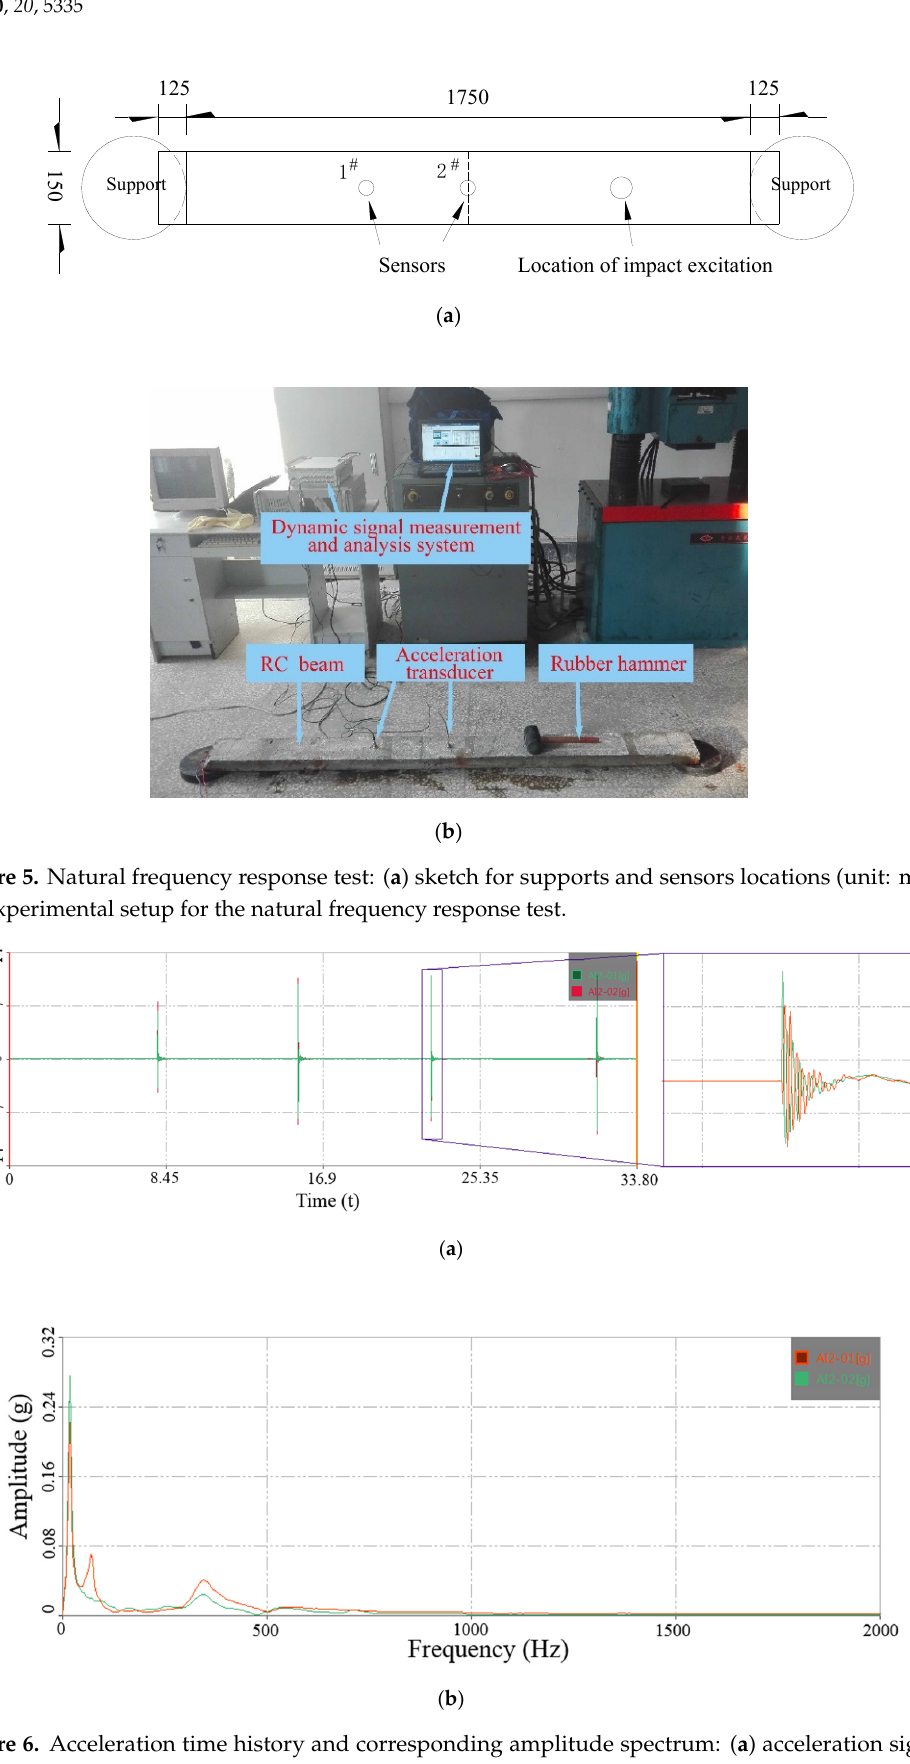
Figure 6. Acceleration time history and corresponding amplitude spectrum: ( a ) acceleration signal history; ( b ) amplitude history; ( b ) amplitude spectrum.